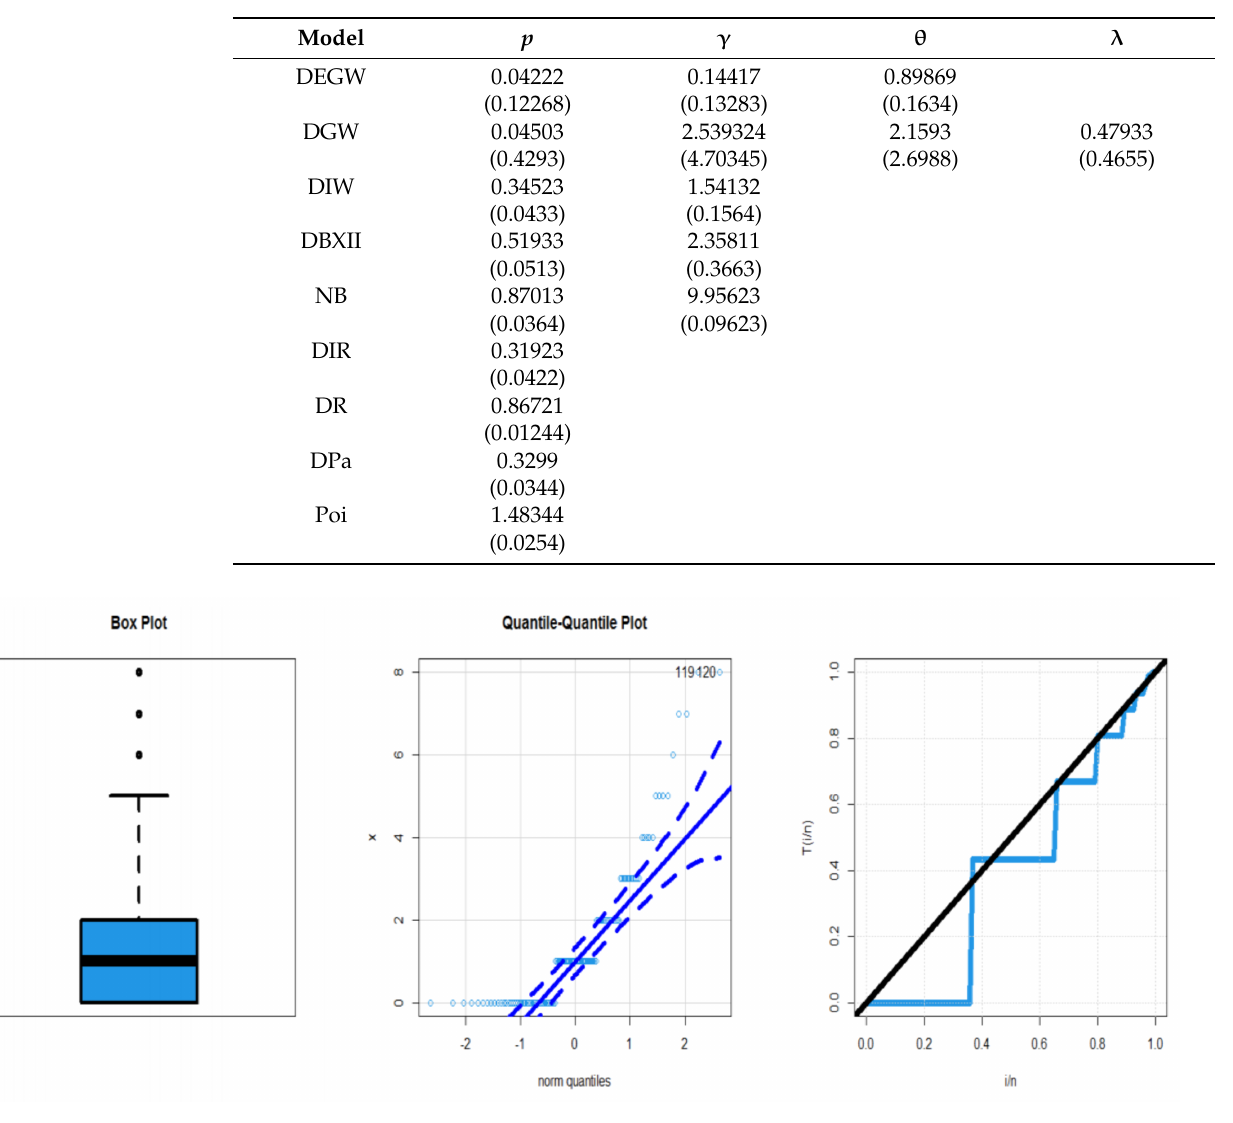
Table 19. The MLEs (and their corresponding St.Ers) for dataset IV.